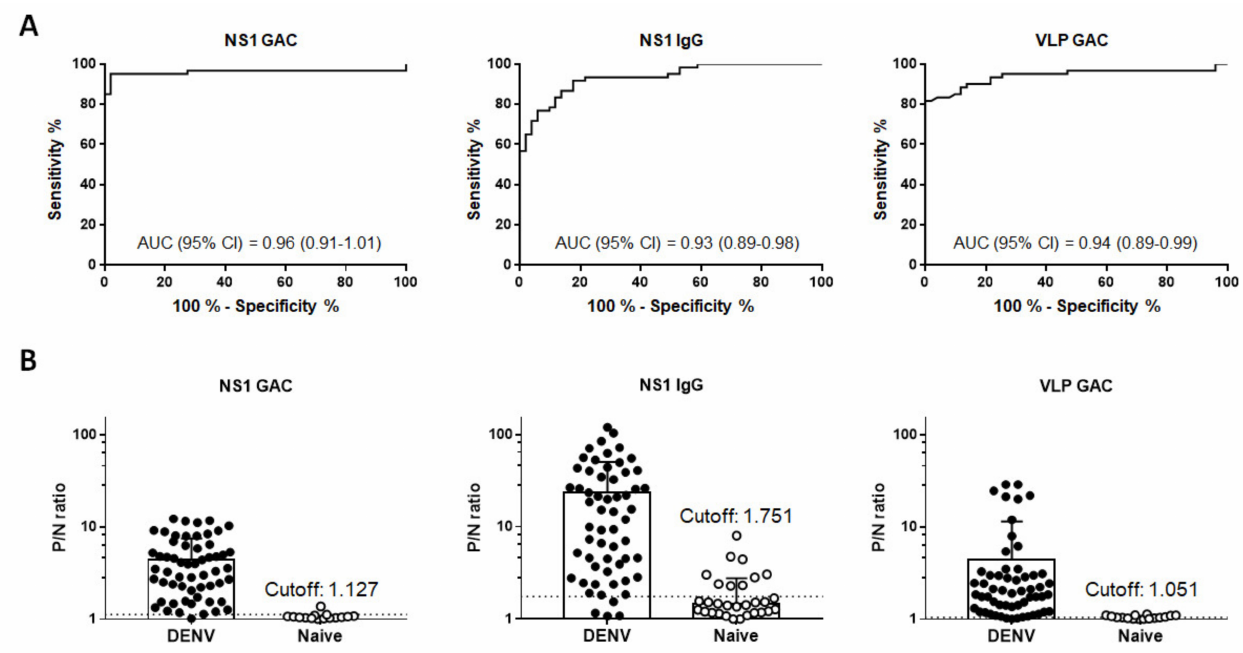
Figure 4. Diagnostic performances of NS1 GAC-, indirect NS1 IgG, and VLP GAC–ELISAs. DENV2 + 3 VLP and NS1 antigens were used in the predepletion and subsequent NS1 GAC–ELISA. Combined DENV1–4 NS1 antigens were used in the indirect NS1 IgG ELISA. DENV2 + 3 VLP antigens were also used in the VLP GAC–ELISA. ( A ) Comparison of the diagnostic performances between NS1 GAC-, indirect NS1 IgG and VLP GAC–ELISAs, as depicted by the fitted receiver operating characteristic (ROC) curves based on P/N ratio values from 60 late convalescent-phase DENV-infected sera and 51 negative control sera. ( B ) The optimal P/N ratio cutoffs (dotted lines) were determined by the magnitude of the positive likelihood ratio (LR + ) using the formula: LR + = sensitivity/(100 − specificity). All data were obtained from two independent experiments with duplicates. Error bars indicate standard deviations of